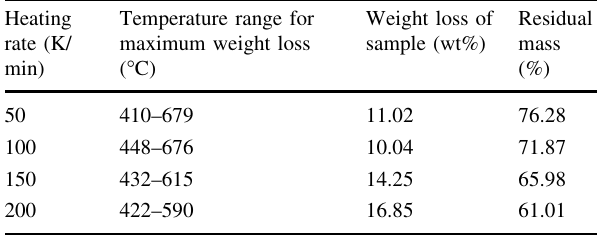
Pyrolysis characteristics and kinetics of Indian low rank coal using thermogravimetric Table 3 Temperature range for maximum weight loss of coal sam- ples with weight loss (%) and residual mass at heating rates (50,